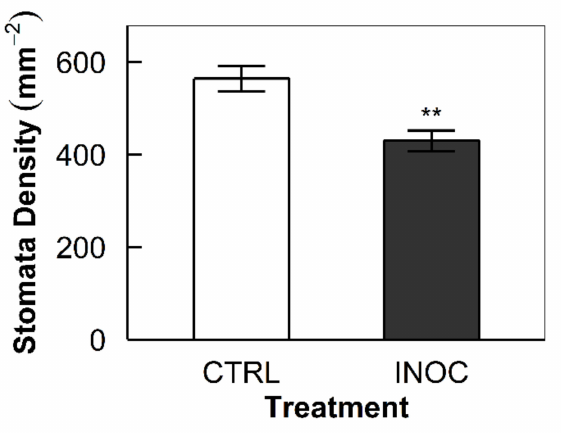
Figure 3. Stomata density of the apple tree leaves: Bars indicate the means of the replicated samples from each treatment group ( n = 8, CTRL and INOC for mock-inoculated control and endophyte-inoculated group, respectively). Error bars represent the standard errors of the means (** p =